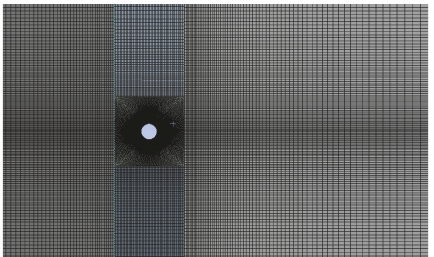
Figure 4: The mesh graph for the entire computational